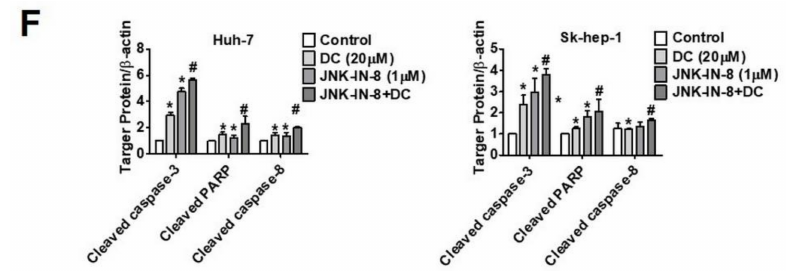
Figure 6. Dehydrocrenatidine inhibited the expression of phosphorylated JNK and regulated apop- tosis process through MAPK pathways in hepatoma cell lines. ( A ) After treated with indicated concentrations of 0, 5, 10, and 20 µ M of dehydrocrenatidine for 24 h, cell lysates were detected by Western blot with antibodies against of p-ERK1/2, p-AKT, p-p38, p-JNK1/2. ( B ) The graphs show quantitative analysis of protein expression of Huh-7 and Sk-hep-1 cell lines. ( C ) Huh-7 and Sk-hep-1 cells were pretreated with SP600125 for 1 h, and then incubated in the presence or absence of 20 µ M dehydrocrenatidine for total 24 h. Cell lysates were detected by Western blot with antibodies against of cleaved caspase-8, -3, and PARP levels. ( D ) Quantification of protein expression levels in two hepatoma cell lines. ( E ) Specific JNK inhibitor, JNK-in-8, was involved in dehydrocrenati- dine treatment (20 µ M). The expression of cleaved caspase-8, -3, and cleaved PARP (red arrows) were detected by Western blot. ( F ) The graphs show quantitative analysis of protein expression of Huh-7 and Sk-hep-1 cell lines. All quantitative data of protein expression after being adjusted with β -actin. Student’s t test was applied to determine statistical significance in three experiment. * represented p < 0.05, compared with the control group. # represented p < 0.05, compared with the treated dehydrocrenatidine alone